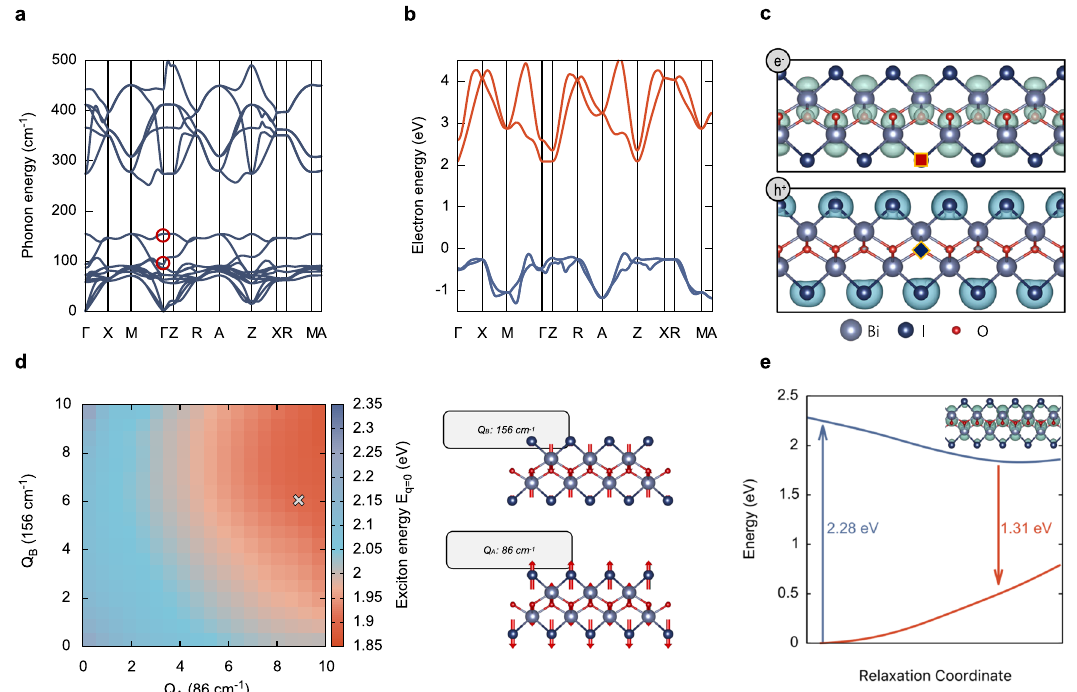
Fig. 2 | First principles studies of BiOI. a , Phonon dispersion curve of bulk BiOI. Redcirclesindicatethetwo A 1g phononmodesQ A andQ B . b Fullyrelativisticsingle- shot GW band structure of BiOI. The highest occupied state is set to 0eV c Top: spatial distribution of the electron constituting the lowest-lying direct exciton when the hole (red square) is fi xed on an iodine atom. Bottom: spatial distribution of the hole constituting the lowest-lying direct exciton when the electron (blue square) is localised on an oxygen atom. d Two-dimensional cut of the potential energy surface corresponding to the lowest-lying direct exciton. The axes corre- spond to the positive displacements along the Raman active modes illustrated on theright-handside,withtheminimumlabelledbyagreycross.Q A =10corresponds